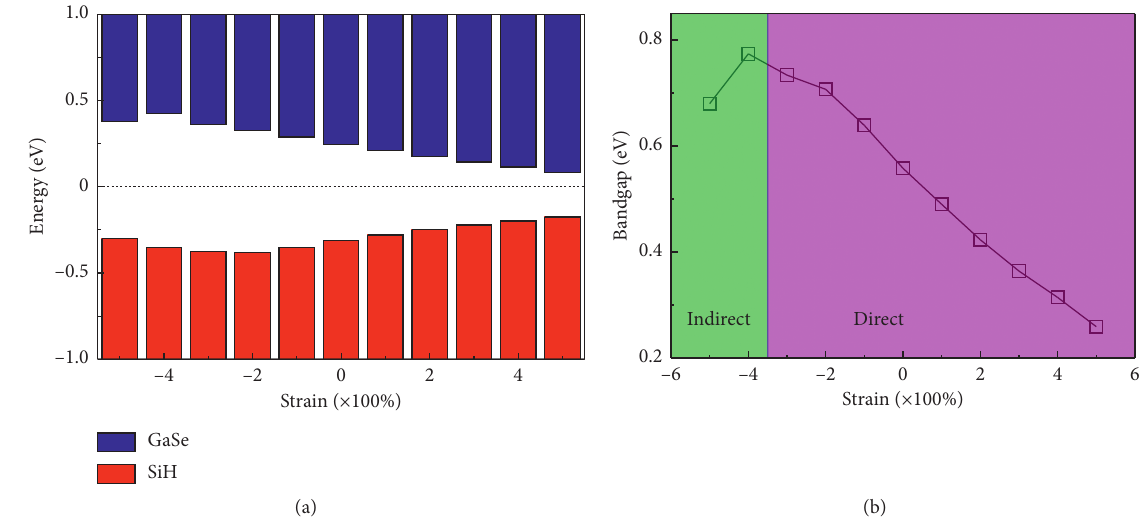
Figure 4: The (a) band edge and (b) band gap as a function of the strain strength in the GaSe/SiH vdW